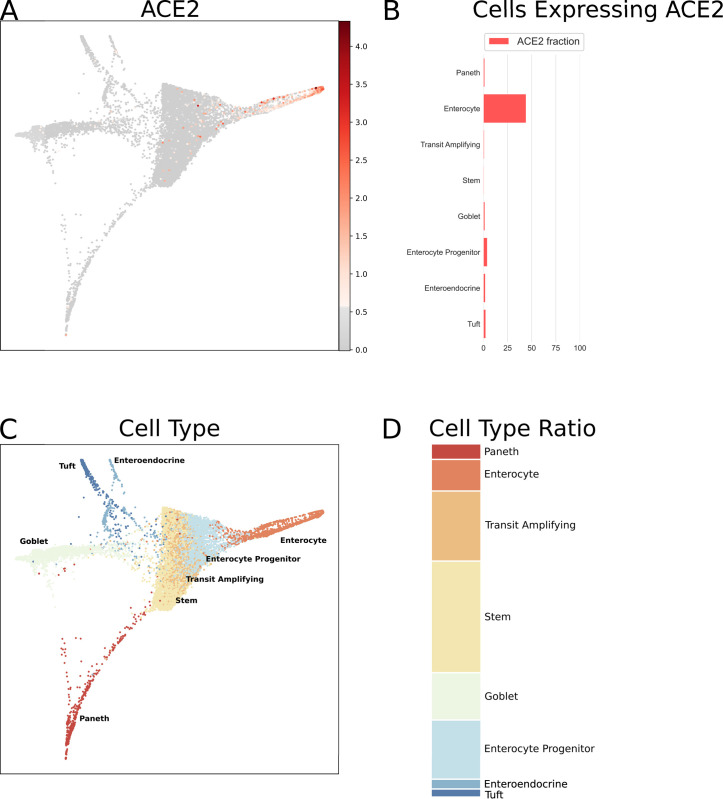
Single cell RNA-Seq analysis of mouse intestinal epithelial cells.Data is from GEO dataset GSE92332 [52]. ACE2 mRNA expression as normalized, batch-corrected counts is shown for comparison in upper panel. The force directed layout plot was computed and visualized in ScanPy [54]. For each cell type the ratio of cells expressing ACE2 is presented in addition to a stacked barplot of the relative cell type frequencies in the whole dataset.